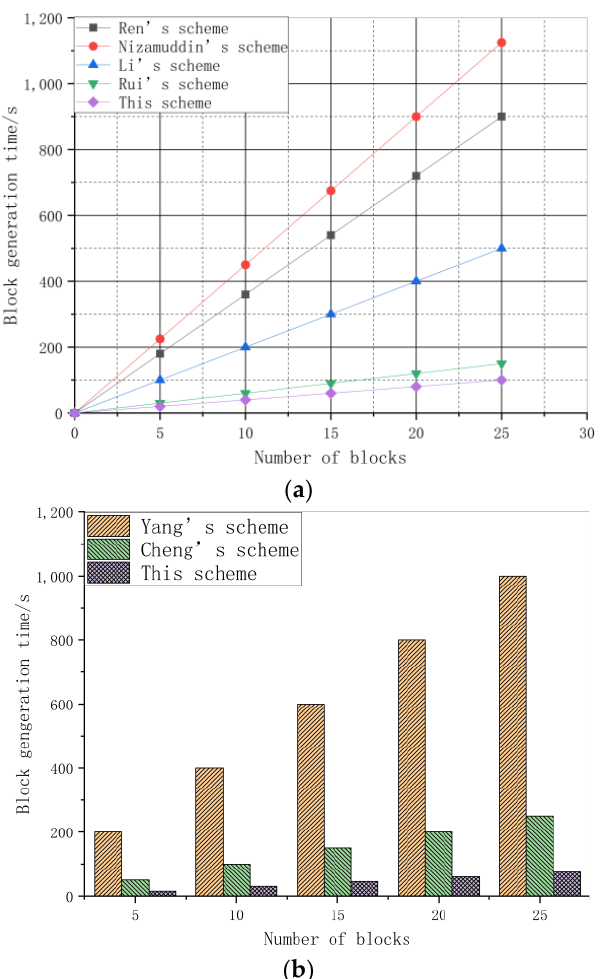
Figure 9. Experimental results of block generation time: ( a ) Secure storage chain; ( b ) deletion verification chain.